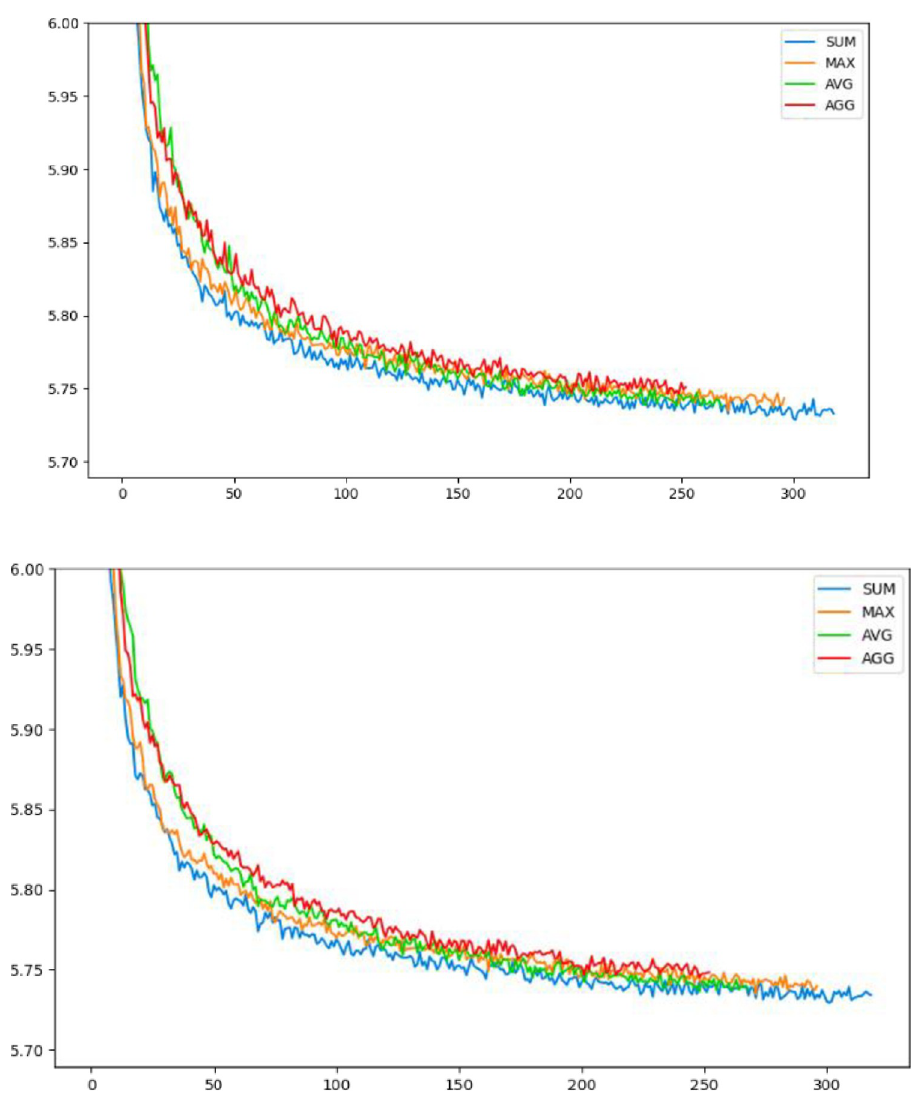
Fig 3. Training performance for the actor (on Top) and the critic (on Bottom) where the total tour length on the y- axis and the number of epochs on x-axis indicating that when we apply the sum operation between the two attention’s vectors, the model converges a little fast compared with the